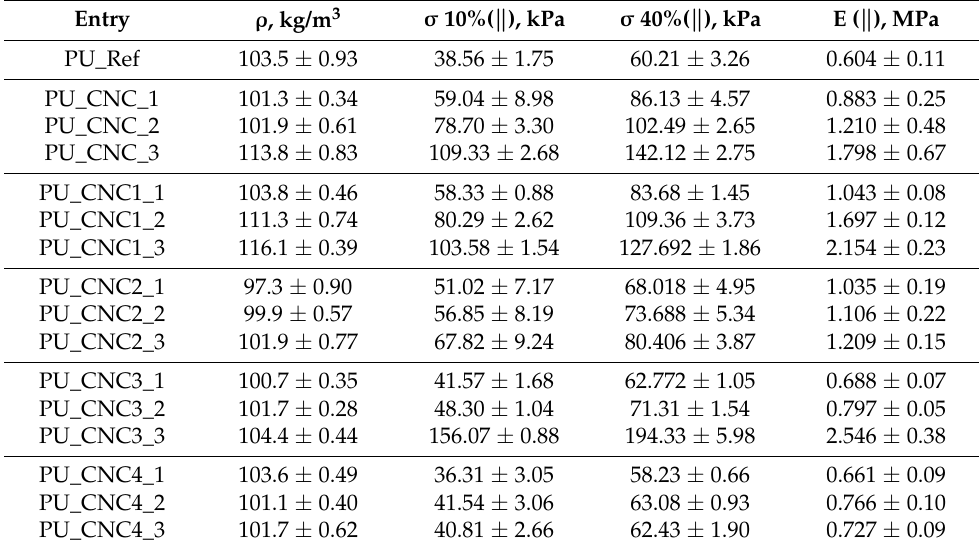
Figure 8. Stress–strain graphics of the characterized samples. In ( a – e ), the green, the blue, the red and the orange lines are representative of samples with 3%, 2%, 1% and 0% content of the relative filler, respectively. In ( f ) are condensed the outcomes of the mechanical tests on those samples with the highest content of filler. Table 6. Mechanical and structural properties of the foams .